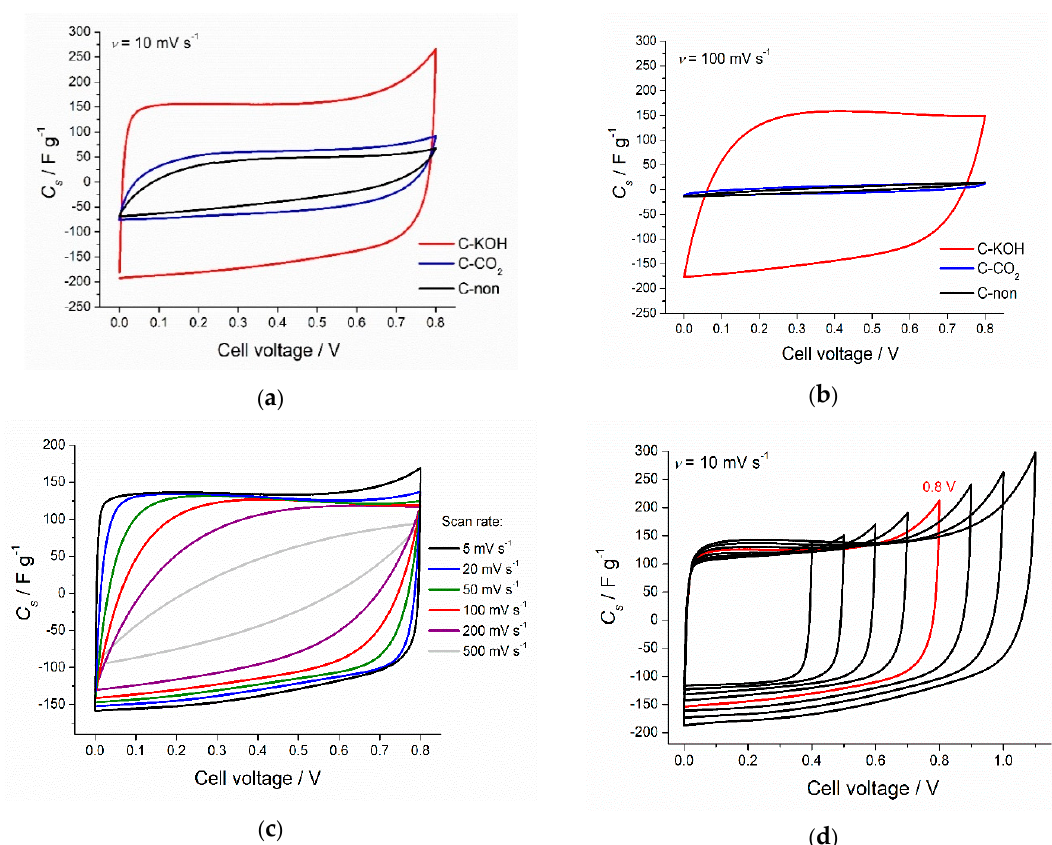
Figure 3. CV curves of the chestnut-derived activated carbons recorded at 10 mV s − 1 ( a ), and at 100 mV s − 1 ( b ). CV curve for chemically activated carbon (3:1 by weight with KOH) recorded at different scan rates ( c ), and for various potential windows ( d ), CV at 0.8 V (marked red) was selected for further experiments in the two-electrode setup.